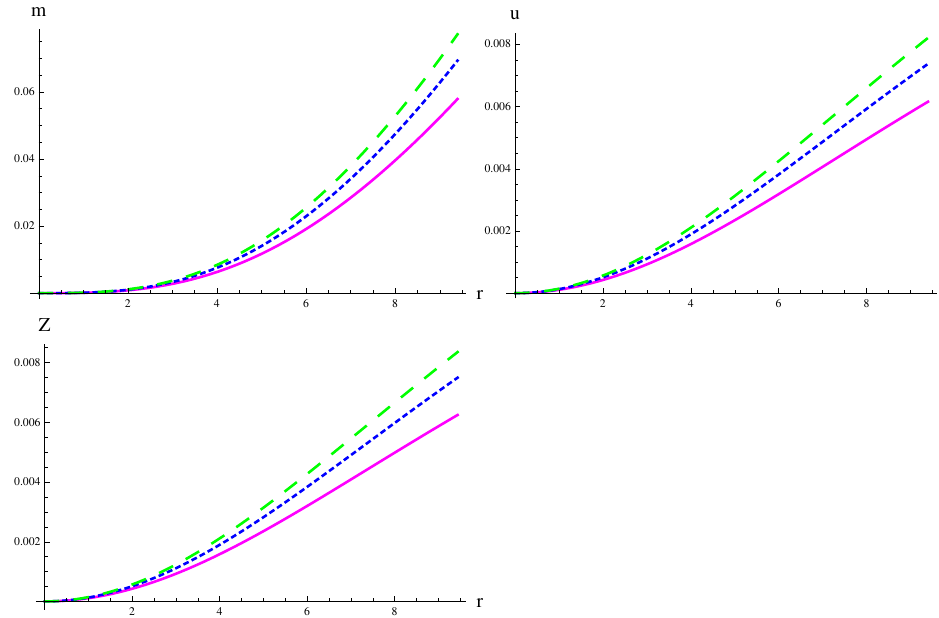
Figure 6. Behavior of m , u and Z corresponding to solution I for Υ = 0.2.